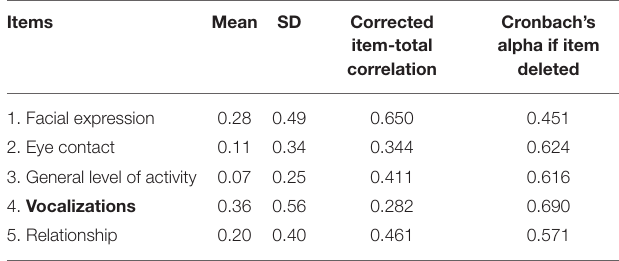
TABLE 2 | Internal consistency of the ADBB scale in the first evaluation.